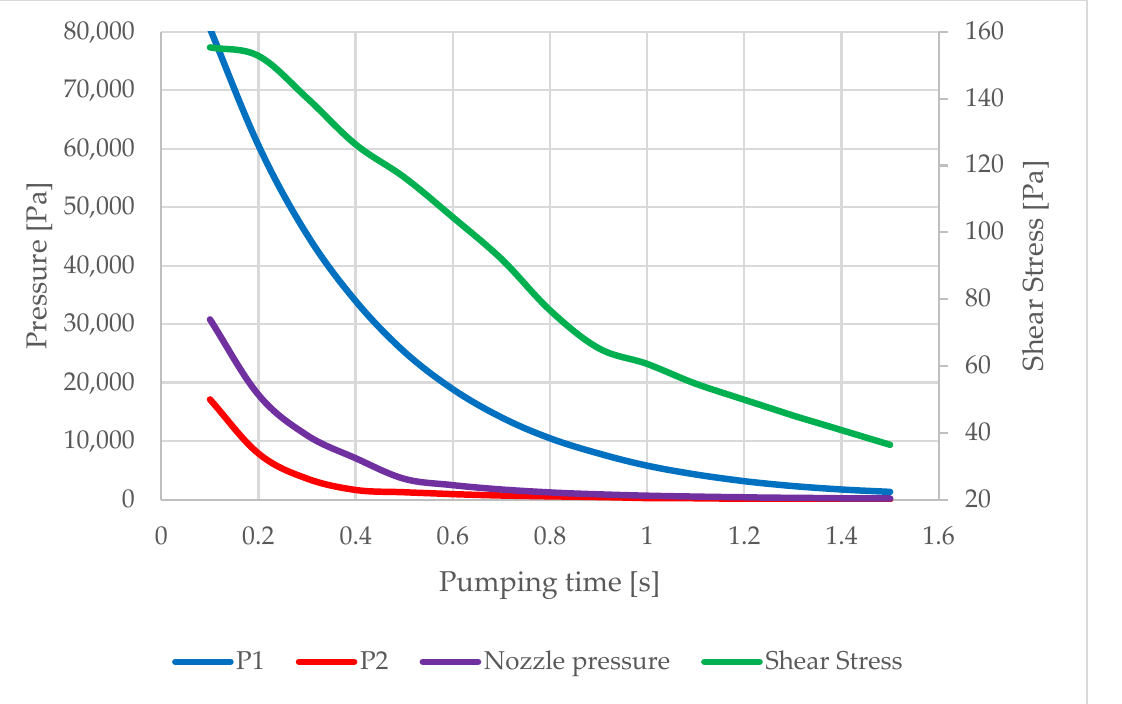
Figure 11. Evolution of monitored variables during chamber pumping.